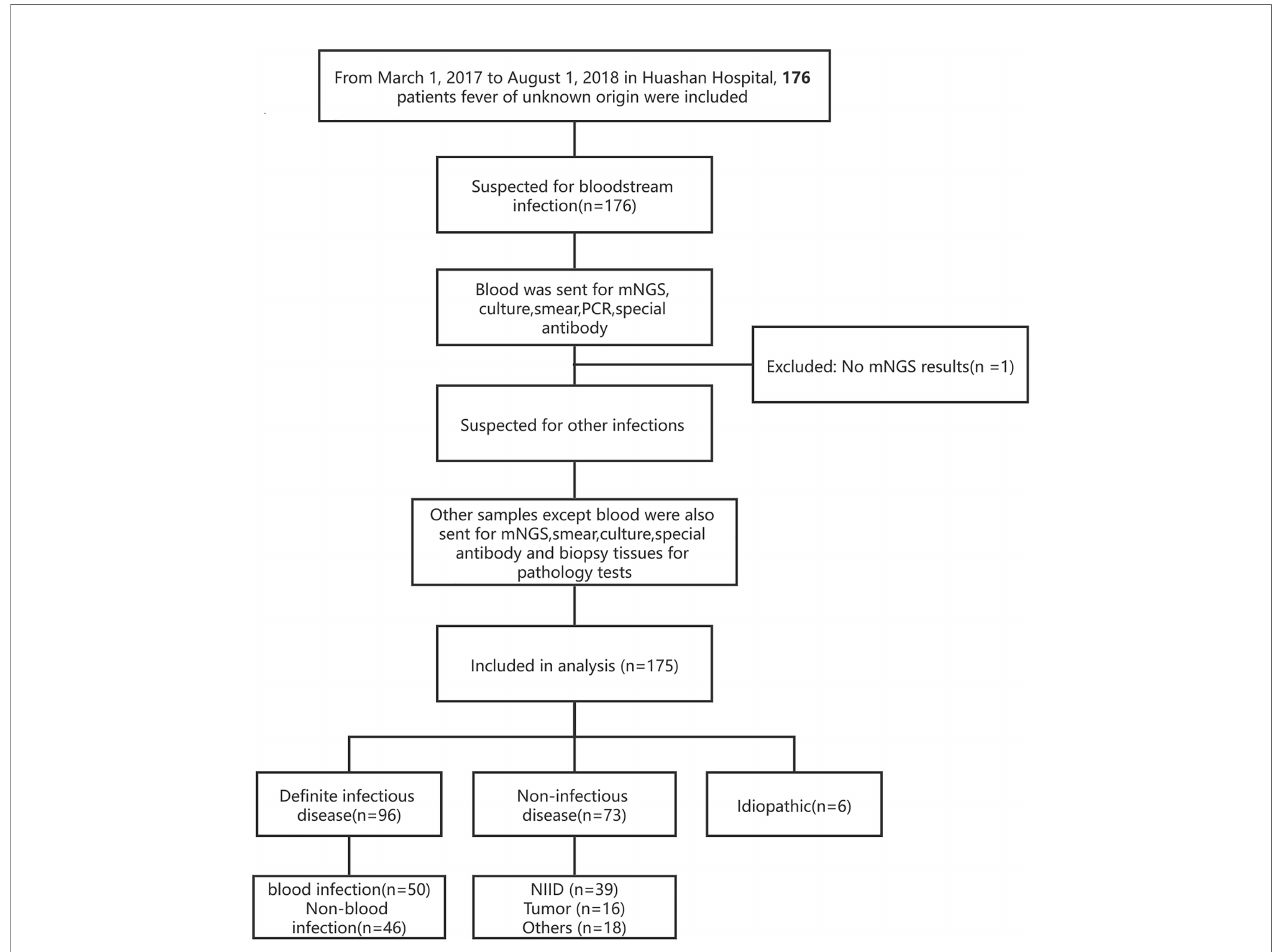
FIGURE 1 | Overview of patients ’ enrollment work fl ow. Flowchart of